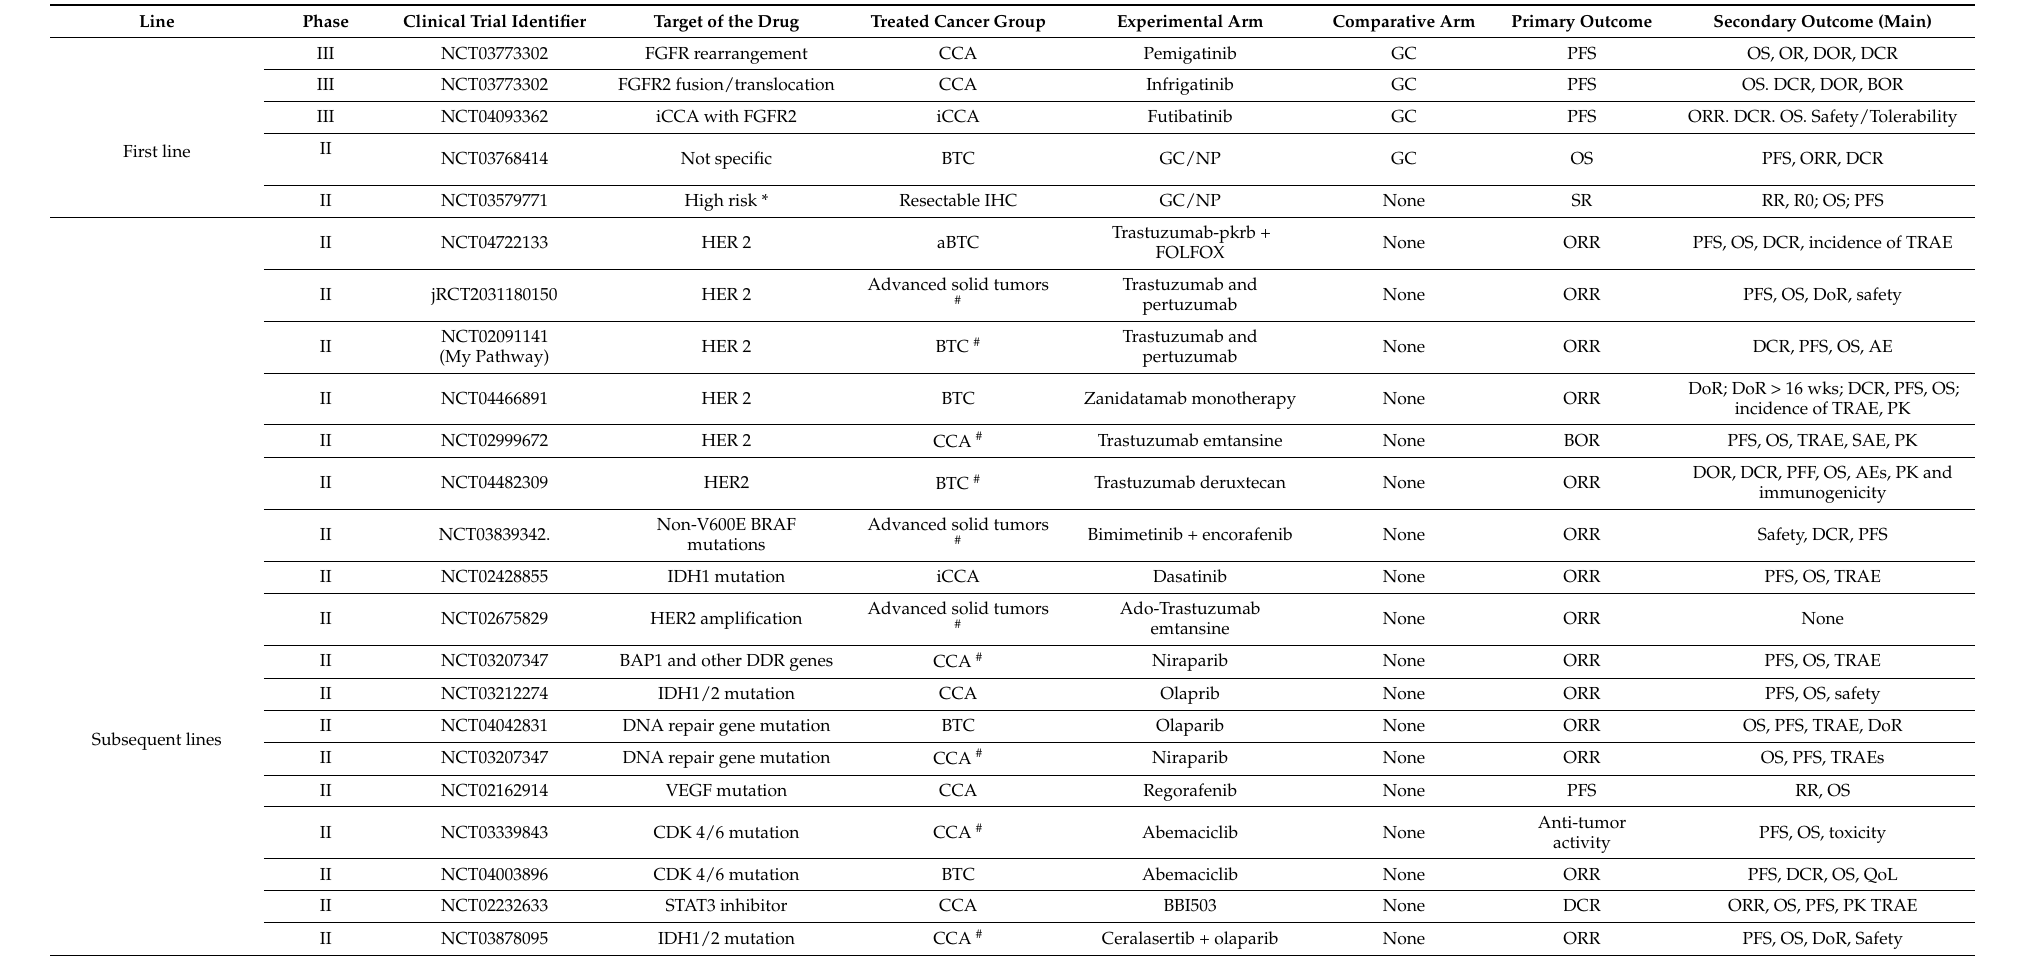
Table 1. Ongoing trials with targeted therapy in biliary tract